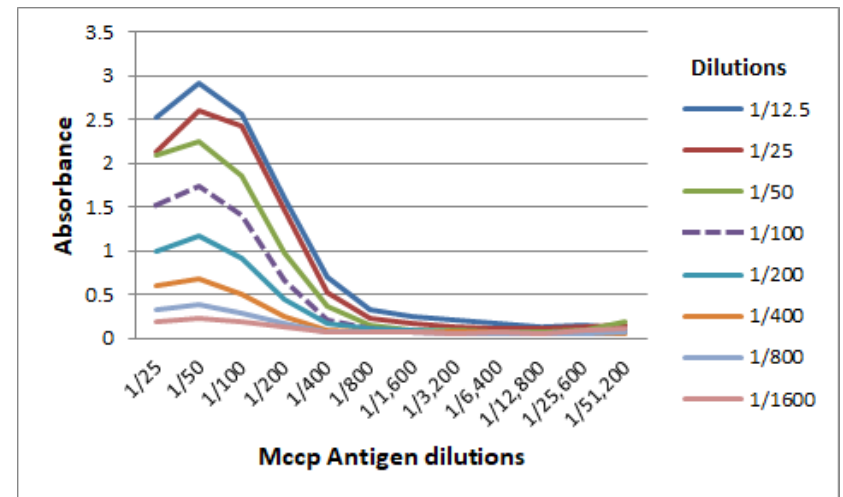
Figure 1. Chessboard titrations of the Mycoplasma capricolum subsp. Capripneumoniae (Mccp) antigen against the Mccp25-horse readish peroxidase (HRP) conjugate. The optical dilution chosen for both coating the antigen and conjugate was 1:100. This was to ensure that the optical density value (absorbance) ranged from 0.5 to 2.